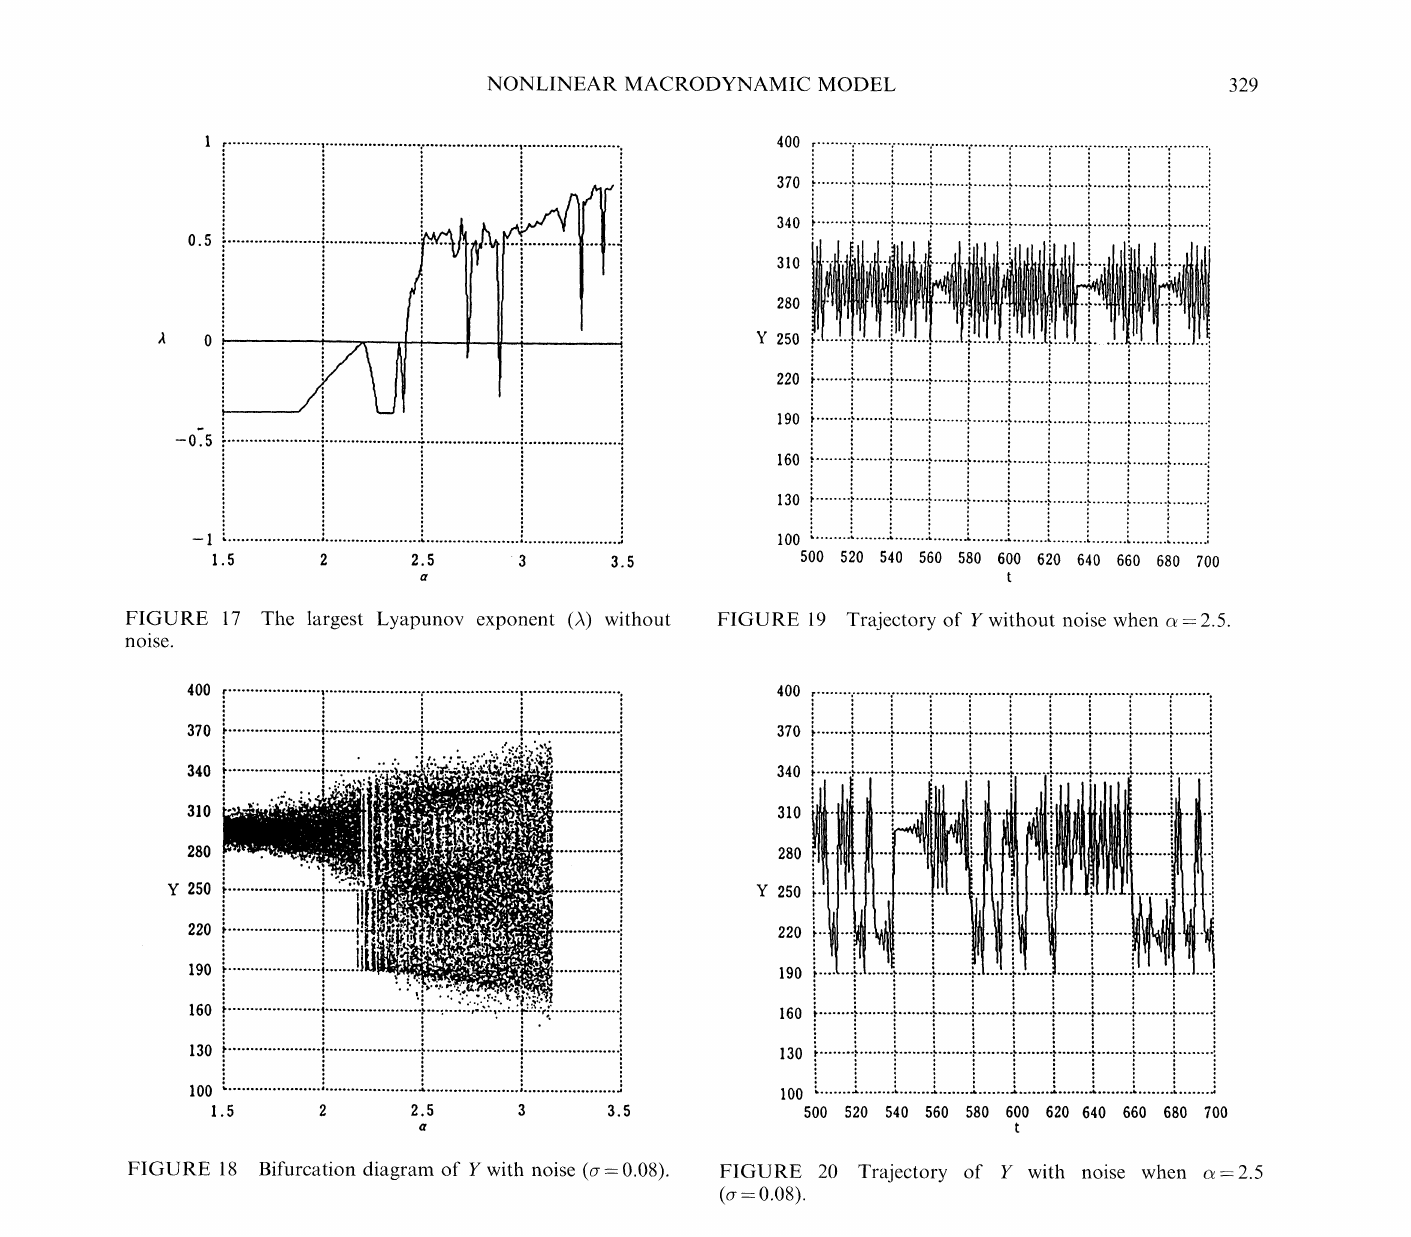
FIGURE 17 The largest Lyapunov exponent (A) without noise.